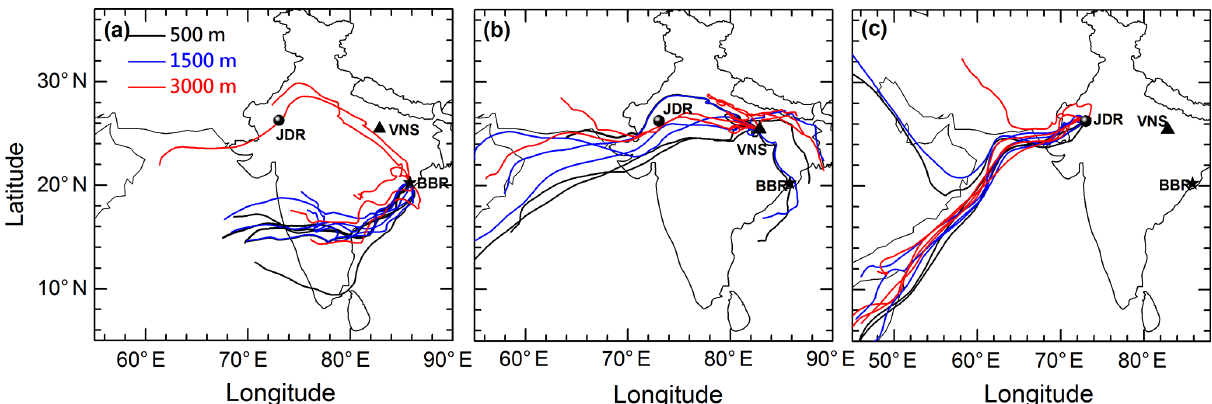
Figure 9. Air mass back trajectories for 5d at 500m (black), 1500m (blue) and 3000m (red) a.m.s.l. over the (a) eastern IGP (BBR),